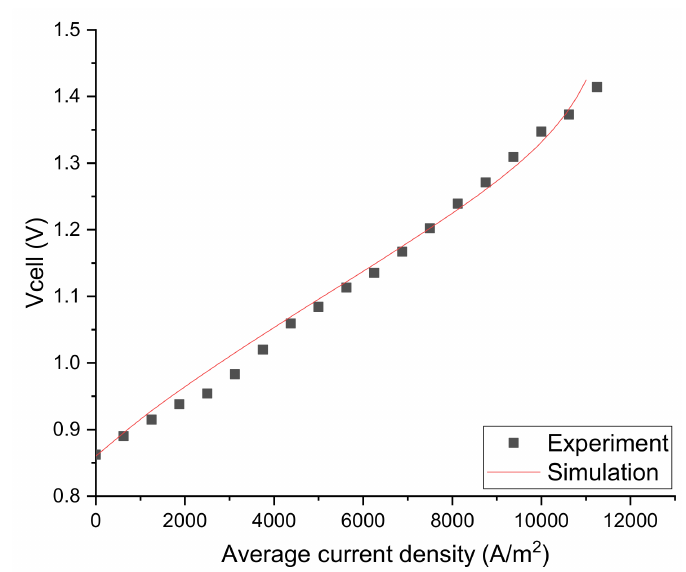
Figure 2. Comparison of experimental and simulated I–V curves.